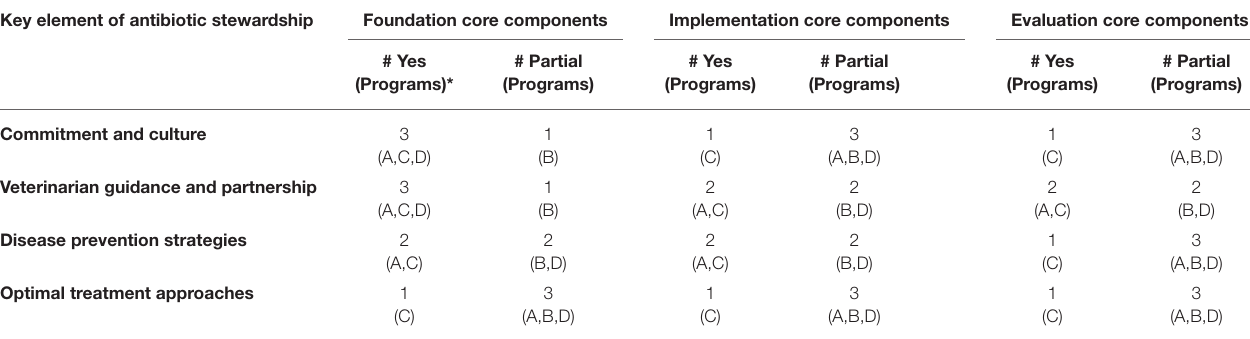
TABLE 2 | Summary of antibiotic stewardship metrics met by the programs evaluated. Key element of antibiotic